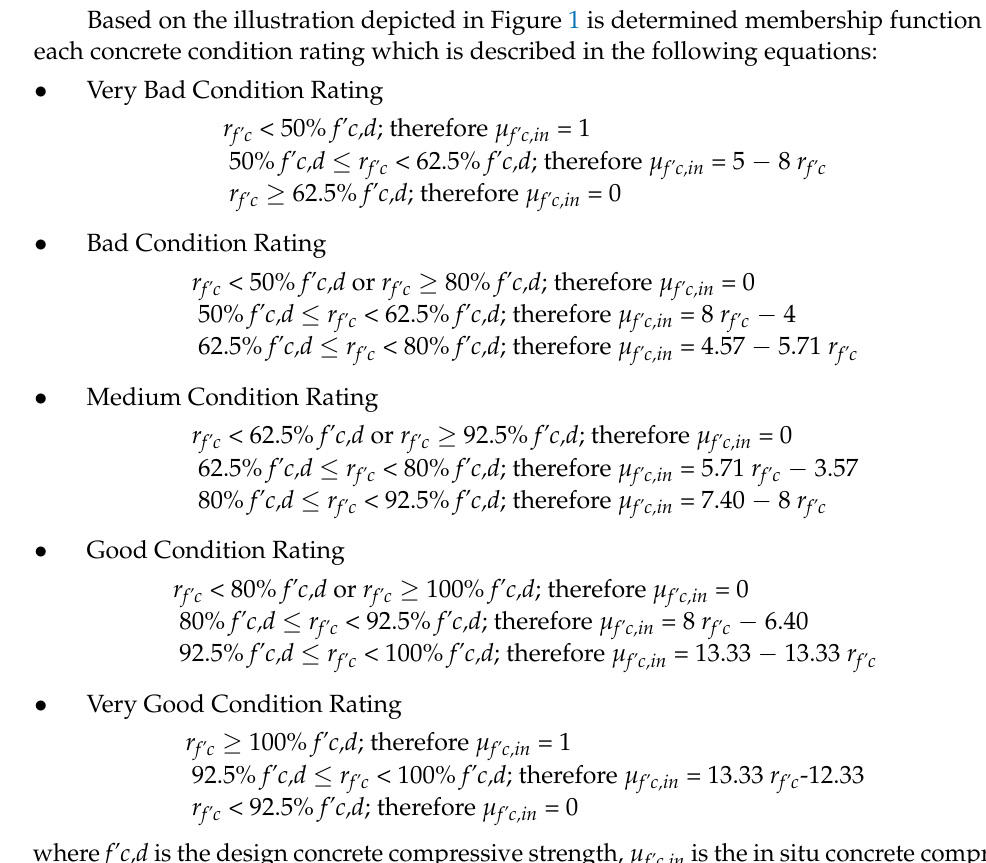
Figure 1. Membership function from concrete compressive